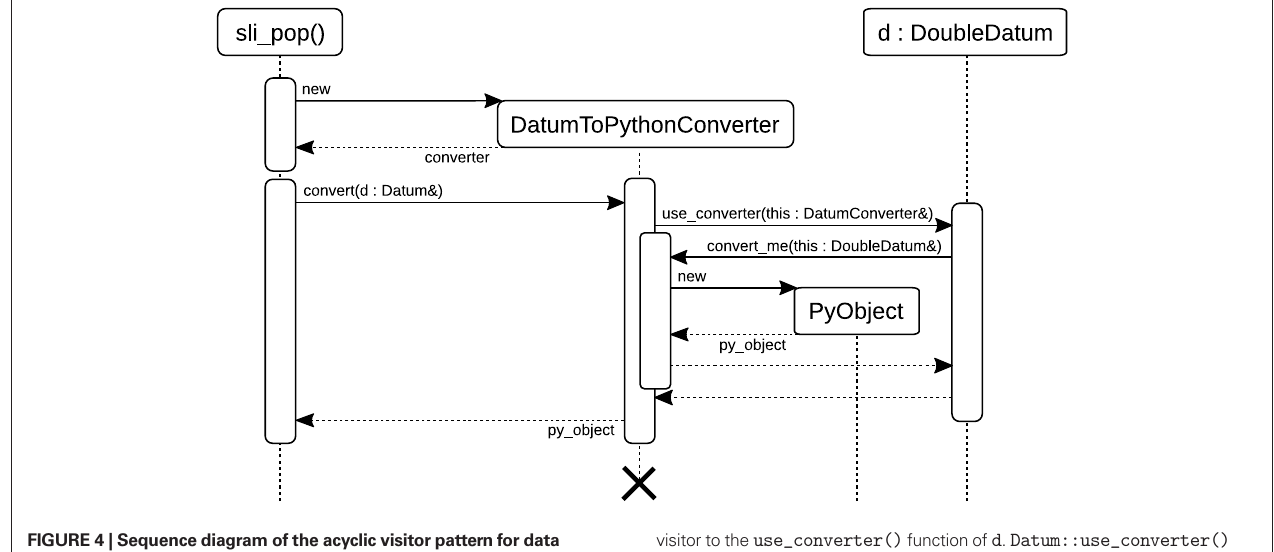
FIGURE 4 | Sequence diagram of the acyclic visitor pattern for data conversion from SLI to Python. For the conversion of a SLI datum d , sli_ pop() creates an instance of DatumToPythonConverter . It then calls the DatumToPythonConverter ’s convert() function, which passes itself as